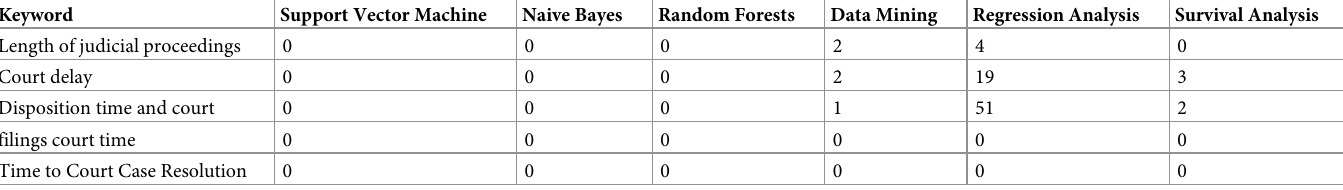
Table 1. Related works on overall case